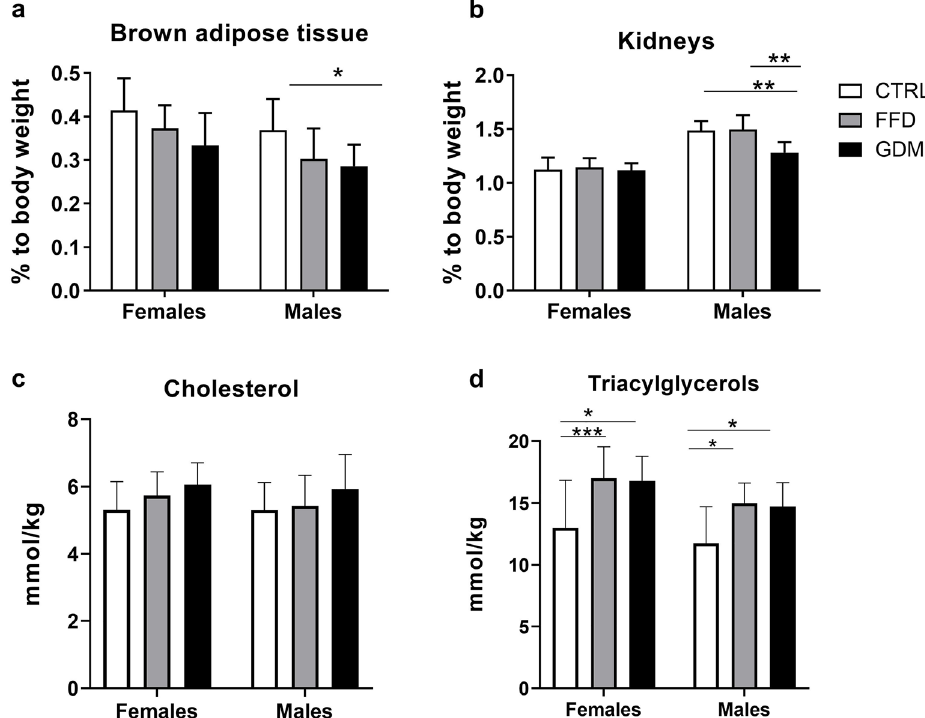
Figure 3. The relative weights of the (a) brown adipose tissue: p group = 0.001, p sex = 0.003, p group*sex interaction = 0.792, and (b) kidneys: p group = 0.002, p sex < 0.001, p group*sex interaction = 0.009; (c) liver content of total cholesterol: p group = 0.601, p sex = 0.514, p group*sex interaction = 0.834; (d) liver content of triacylglycerols: p group < 0.001, p sex = 0.016, p group*sex interaction = 0.862; groups: CTRL offspring of dams consuming control diet, FFD offspring of dams administered fast-food diet (cheeseburgers), GDM offspring of dams with gestational diabetes mellitus; *p < 0.05; **p < 0.01; ***p <